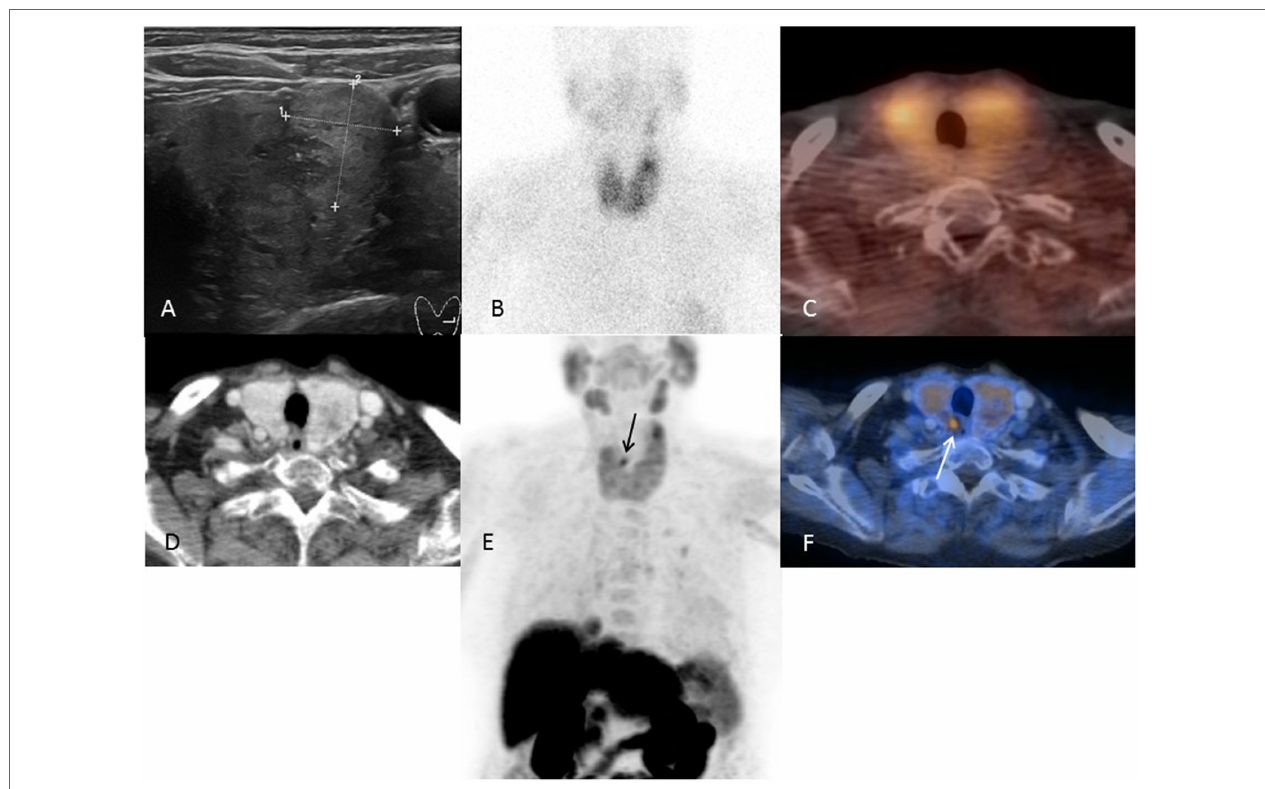
FigUre 2 | A representative case of a patient with multinodular goiter and negative conventional imaging. Images of an 82-year-old patient (patient number 9). Ultrasound (a) showing a bilateral multinodular goiter and no visible parathyroid adenoma. 99m Tc-sestamibi SPECT/CT (B,c) without detection of a parathyroid adenoma. FCH-PET/CT (D–F) with clear visualization of a small parathyroid retrotracheal adenoma at the upper right